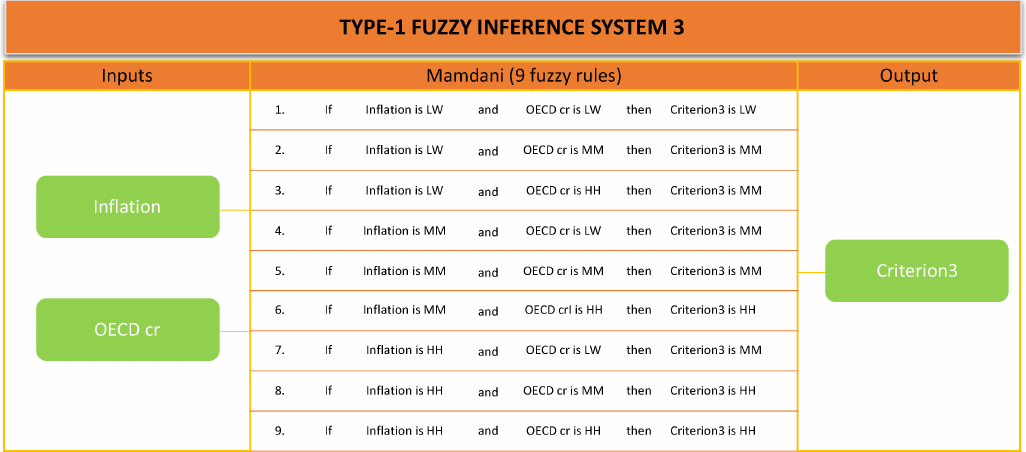
Figure 7. Third Type-1 fuzzy system inflation and OECD country risk variables.